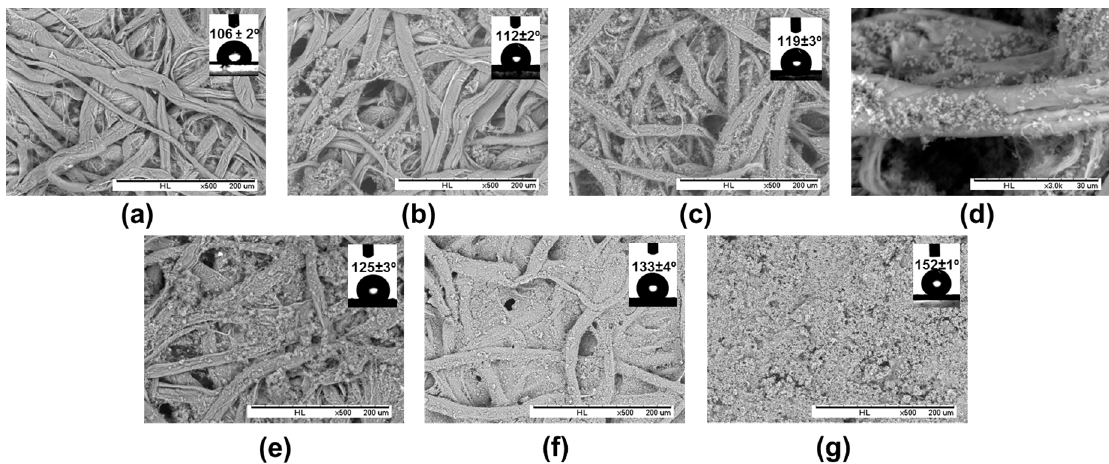
Figure 7. Scanning electron microscopy for PHB-SP- or PHB-SP/NFC-coated papers from suspensions with different concentrations PHB-SP and NFC: ( a ) non-coated reference filter paper, no PHB-SP and no NFC; ( b ) 5 w / v % PHB-SP, no NFC; ( c ) 20 w / v % PHB-SP, no NFC; ( d ) detail of 20 w / v %